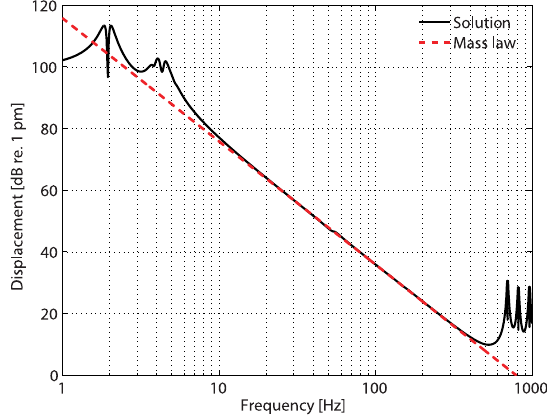
Fig. 5. The vibro-acoustic response, integral of the total displacement of Substructure 3 (solid line), together with a visualisation line show- ing a mass law frequency dependence (dashed line).